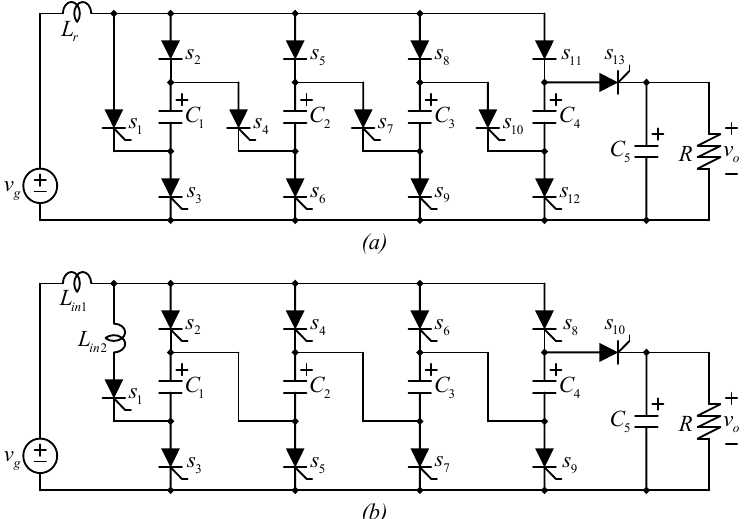
Figure 31. Thyristors-based implementations of the series-capacitor SC converter with resonant charge interchange, ( a ) straight forward realization, ( b ) a simplified version proposed in [44].